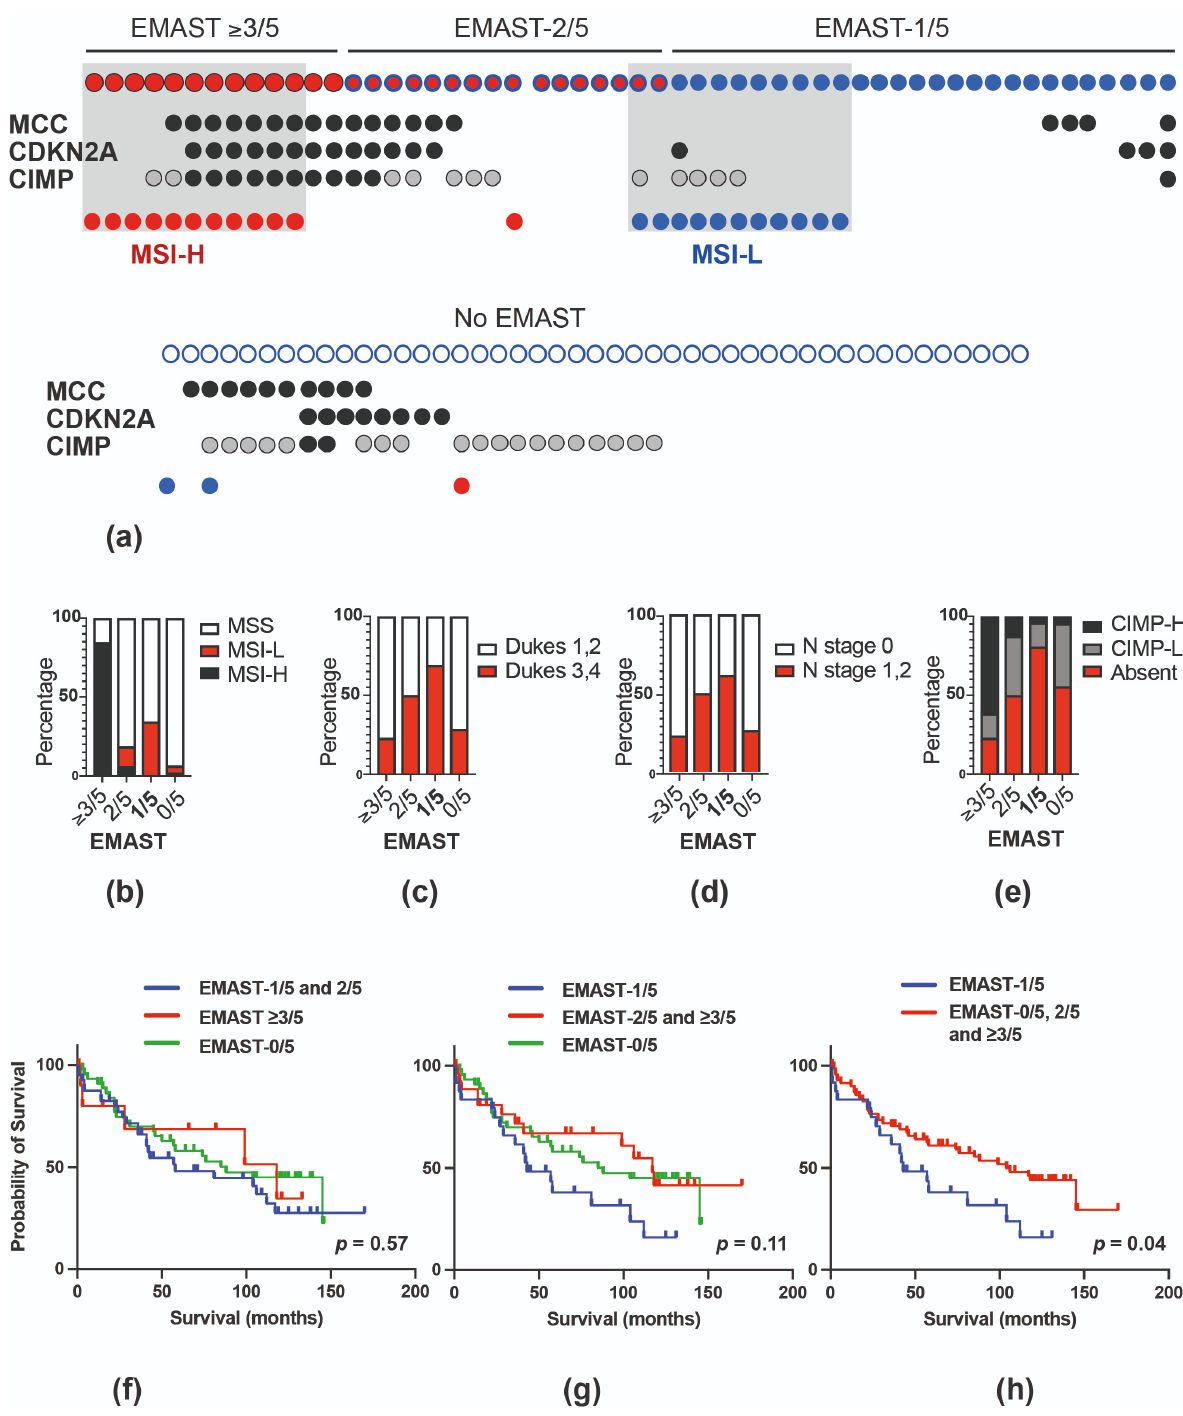
Figure 2. ( a) Presence of CIMP-H, CDKN2A and MCC gene methylation (black), CIMP-L (grey), MSI-H (red) and MSI-L (blue) in 100 colorectal cancers grouped according to EMAST- ≥ 3/5, 2/5, 1/5 or 0/5 status; distribution of MSI status ( b ), Dukes stages ( c ) N stages ( d ) and (e) CIMP status in colorectal cancers grouped according to EMAST- ≥ 3/5, 2/5, 1/5 or 0/5 status (proportions taken from Table 1). Overall survival in patients grouped according to EMAST-positive (1–3 markers out of 5) or EMAST-negative tumours ( f,g ). Overall survival in patients with a single EMAST marker (EMAST-1/5) compared with all other patients ( h